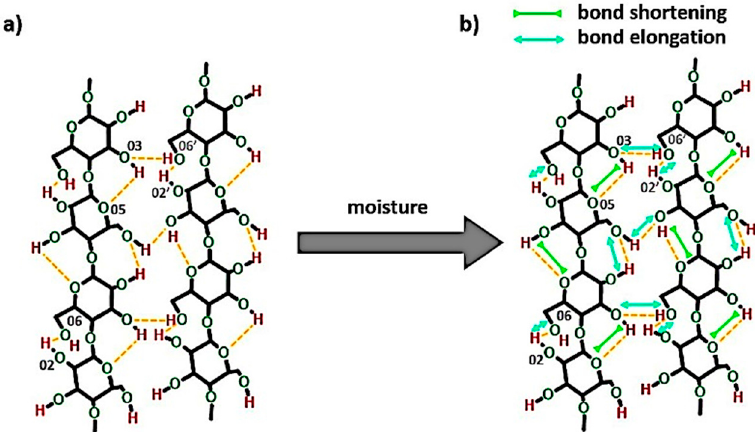
Figure 12. The scheme of the possible changes in the bond lengths while cellulose is subjected to the humid atmosphere (RH = 96%): ( a ) system of hydrogen bonds in the dry cellulose fibers, ( b ) system of hydrogen bonds in the cellulose of (8.0 ± 0.9) wt% moisture content.